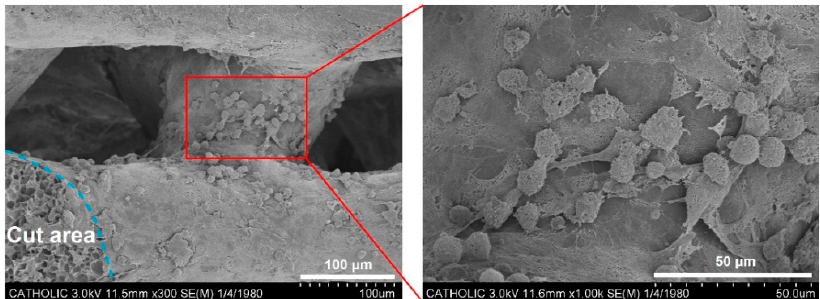
Figure 2. ( a ) Photos and ( b ) scanning electron microscopy (SEM) images of PCL, TA/PCL, BMP-2/PCL, and BMP-2/TA/PCL.